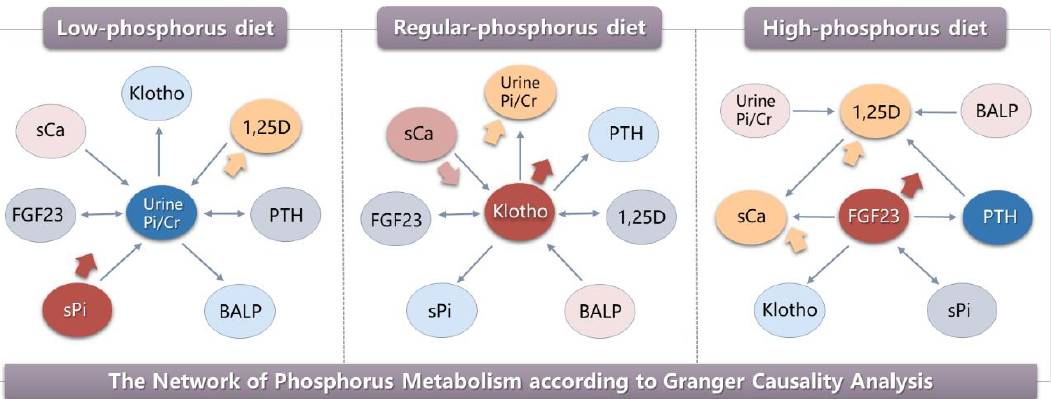
Figure 2. The network of phosphorus metabolism using Granger causality analysis following the low-, regular-, and high-phosphorus diet interventions. Note: Causality graph with the highest betweenness and degree effects following three diet interventions. Betweenness centrality is often used to find nodes that serve as a bridge from one part of a graph to another. The parameter with the highest betweenness was in the center of each graph with all the causal connections associated with this parameter. The thin arrows show the regulatory relationships associated with this phosphatonin. The big orange and red arrows indicate parameters with the highest outdegree and indegree values. Parameters with the highest outdegree value have the most regulating effect over other parameters in phosphorus metabolism. Parameters with the highest indegree value means they were mostly regulated. The head of the arrow represents the cause, and the tail represents the result. Abbreviations: Urine Pi/Cr, urinary phosphorus/creatinine rate; PTH, parathyroid hormone; FGF23, fibroblast growth factor 23; BALP, bone alkaline phosphatase; 1,25D, 1,25-dihydroxyvitamin D3; sPi, serum phosphorus; sCa, serum calcium.